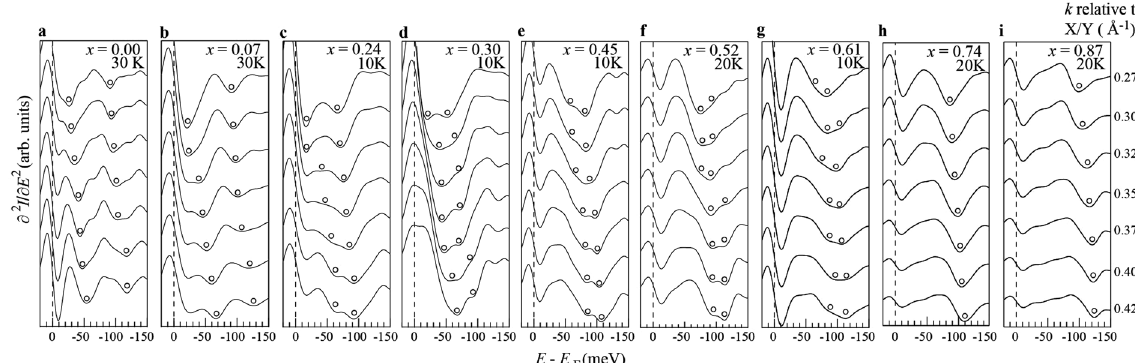
Figure 2. ( a – i ) x dependence of second E derivative EDCs in an interval of 0.025 Å − 1 near X / Y point at 30 K for x = 0.00 and 0.07, 20 K for x = 0.52, 0.74 and 0.87, 10 K for x = 0.24, 0.30, 0.45 and 0.61, respectively. Black open circles represent dip positions in the spectra corresponding to the energy position of the δ hole